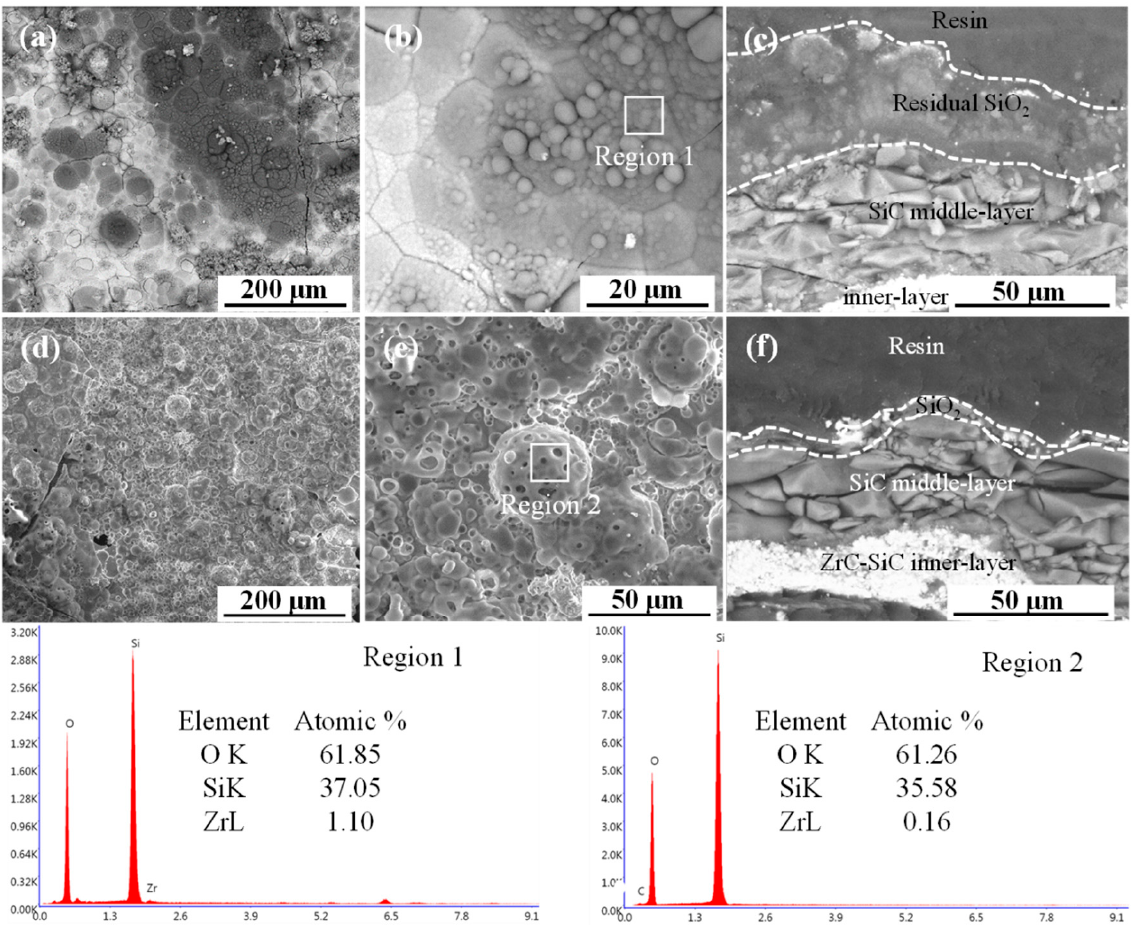
Figure 13. Surface and cross-sectional morphologies of S3-C and S3-D coatings after ablation for 60 s. ( a – c ): S3-C; ( d – f ): S3- D.